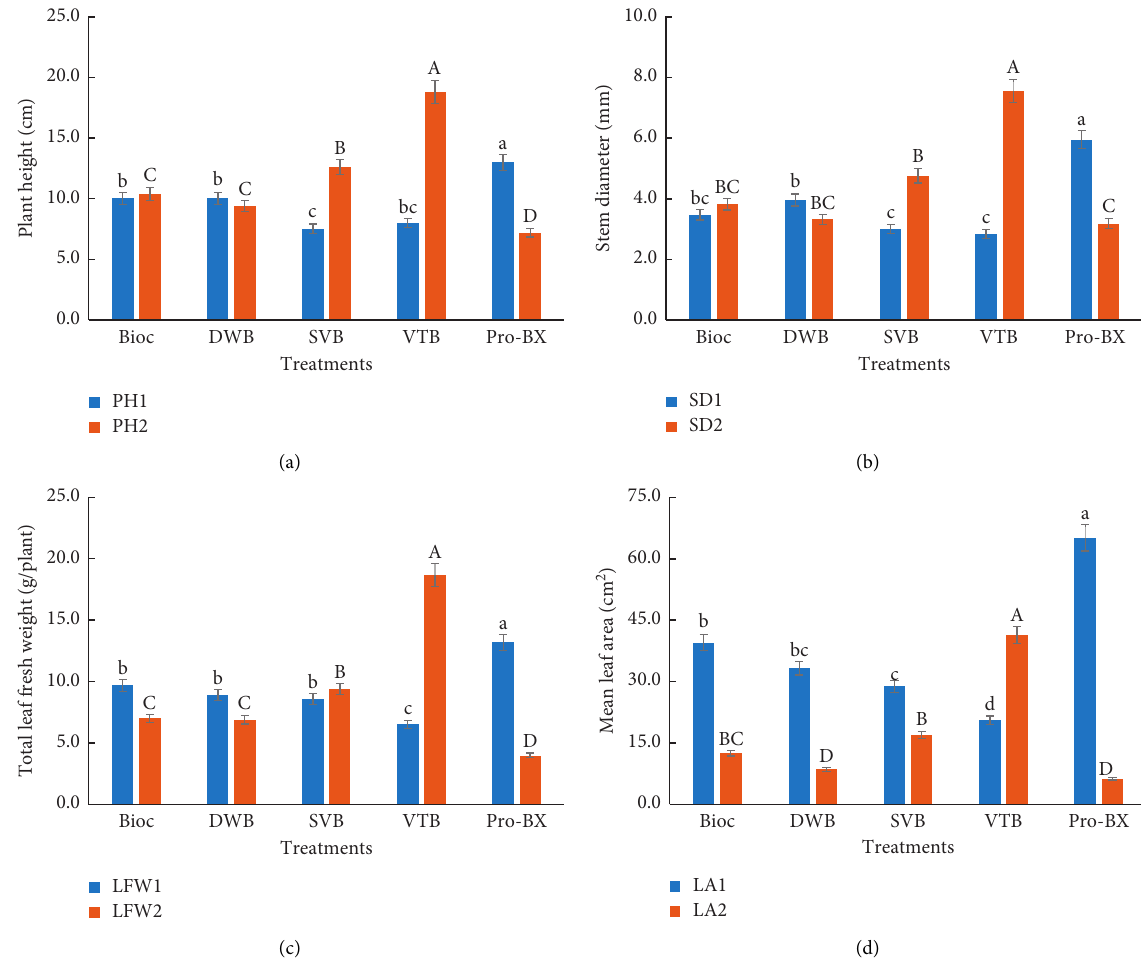
Figure 4: Plant height (PH), stem diameter (SD), leaf area (LA), and total edible leaf fresh weight (LFW) of Swiss chard ( Beta vulgaris subsp. vulgaris) cv. Rhubarb chard as affected by biochar alone (Bioc), deionized water-inoculated biochar (DWB), solid vermicast-inoculated biochar (SVB), vermicast tea-inoculated biochar (VTB), and Promix-BX alone (Pro-BX). Lowercase and uppercase alphabetical letters represent mean separation by the least significant difference ( α � 0.05) at the first (1) and the second (2) harvests, respectively. Vertical lines on bars represent standard error of the means.